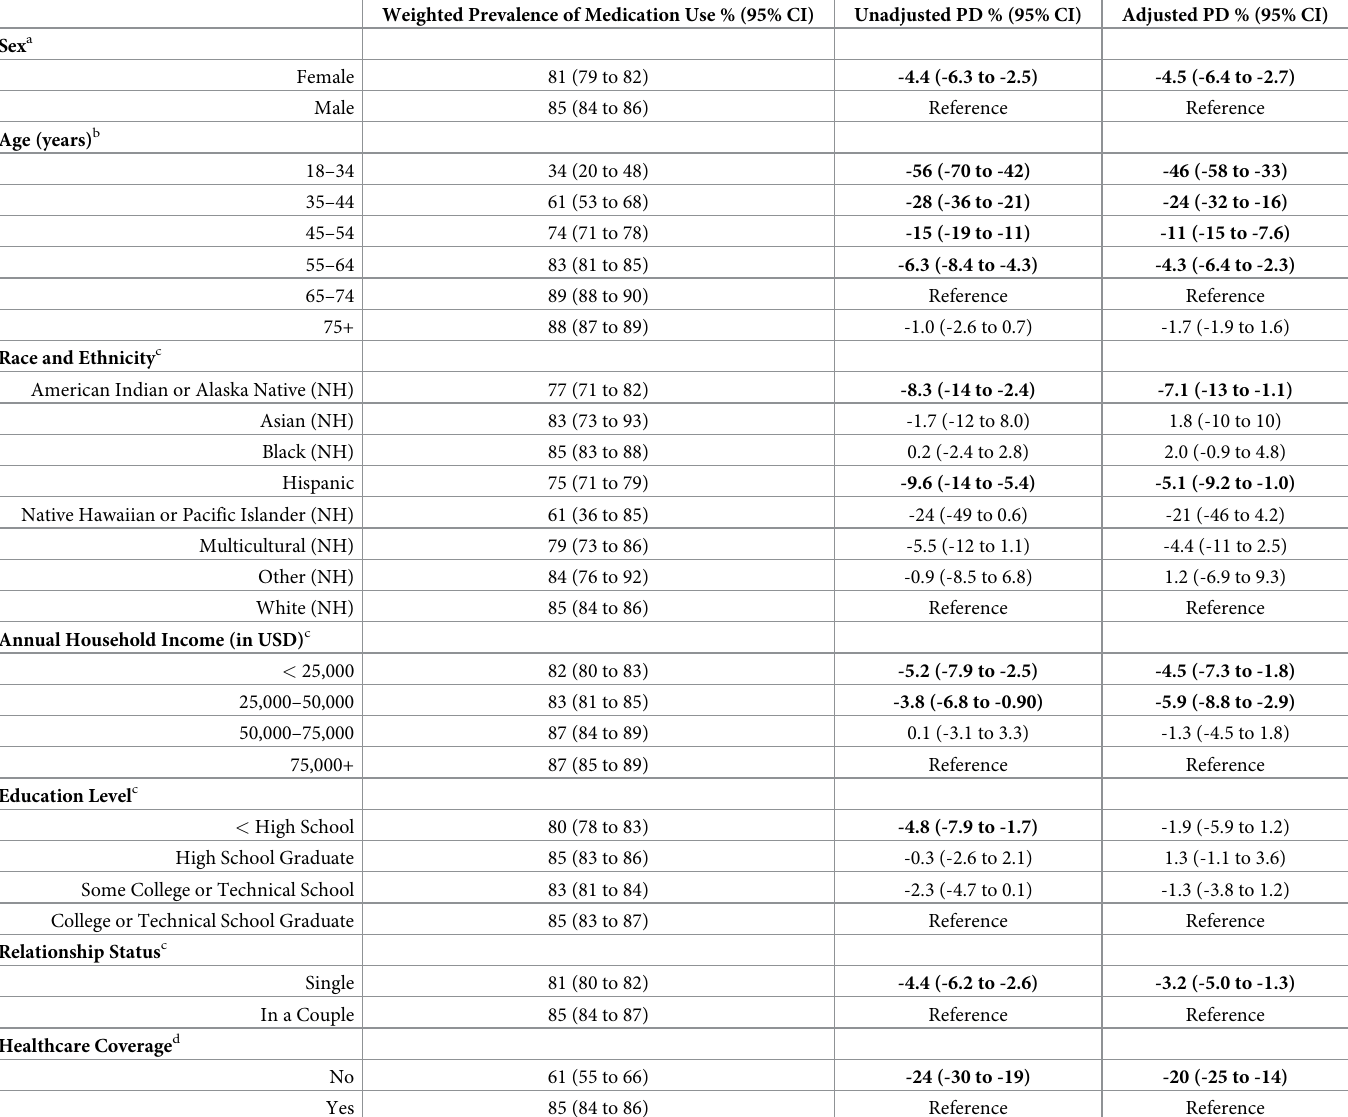
Table 2. Weighted prevalence, unadjusted, and adjusted prevalence differences (PD) of current cholesterol-lowering medication use among BRFSS participants with self-reported history of myocardial infarction and high blood